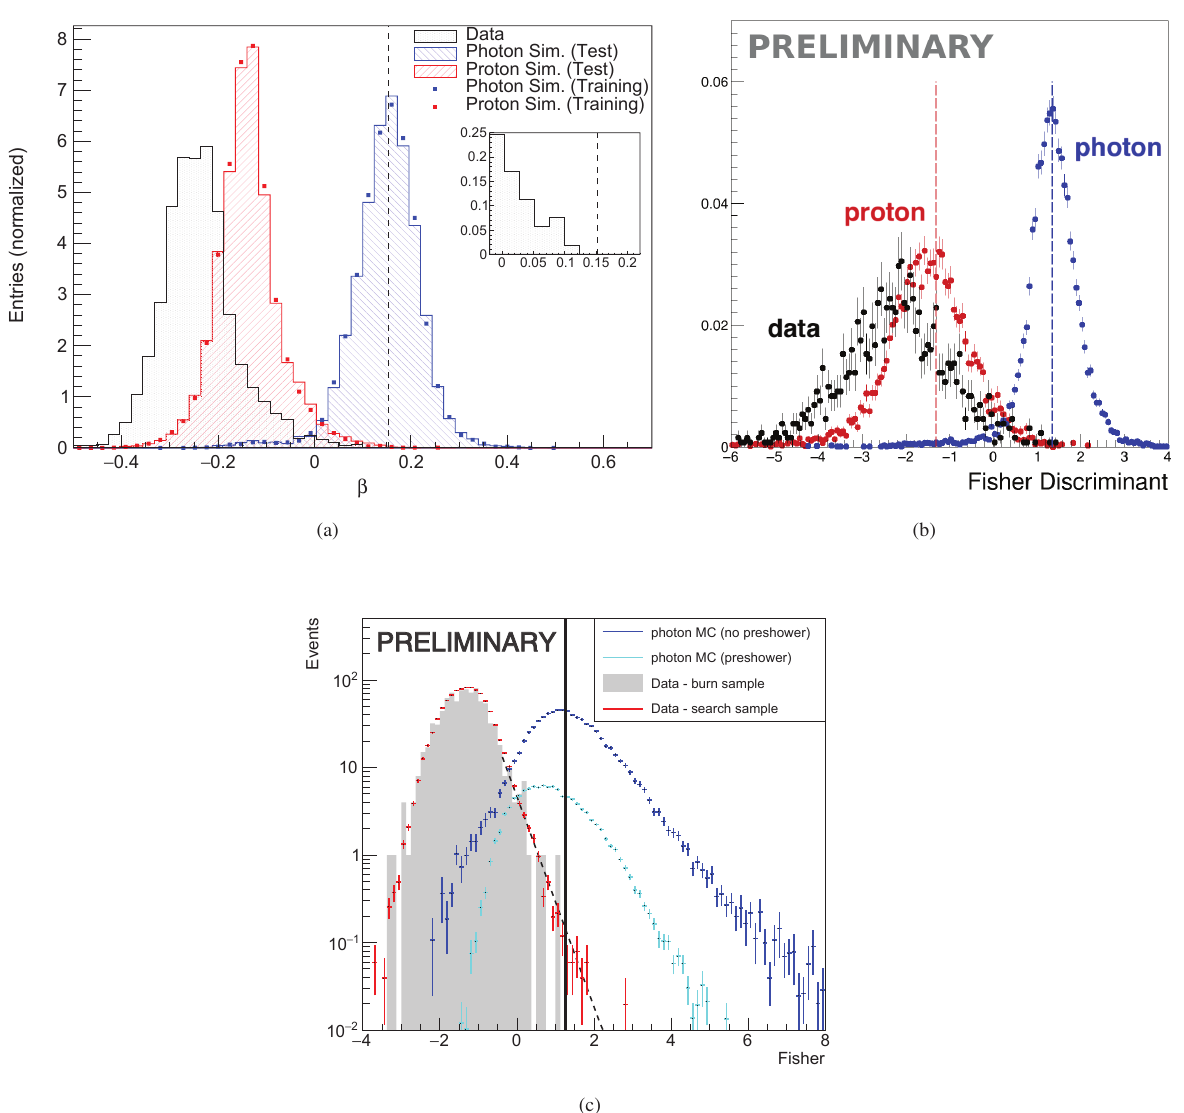
Figure 1. Results of the multivariate analyses used to search for primary photons in the data collected by the Pierre Auger Observatory; (a) energy range between 2 × 10 17 and 10 18 eV, using HeCo data combined with data from the 750m SD array [3]; (b) energy range between 10 18 and 10 19 eV using data from the main fluorescence telescopes and the 1500m SD array [4]; (c) energy range above 10 19 eV using only data from the 1500m SD array